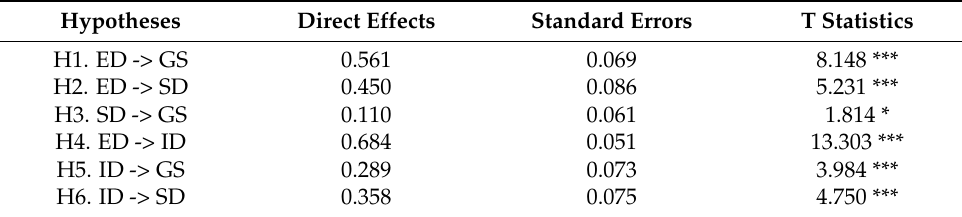
Table 7. Hypotheses